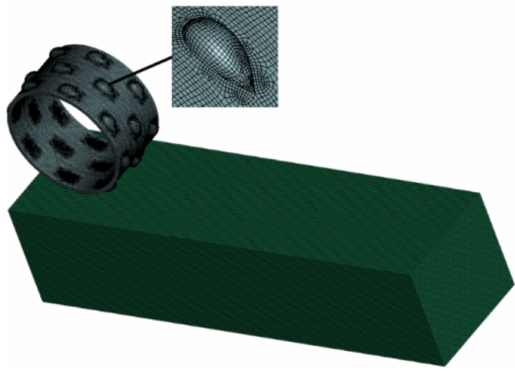
Figure 7. Finite element model of roller and soil.